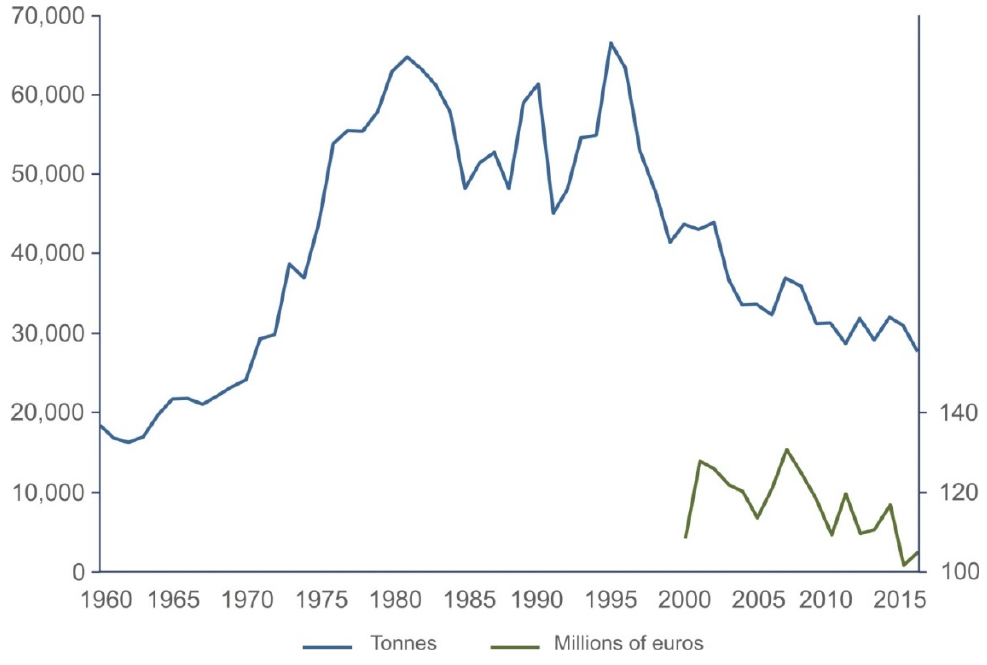
Figure 3. Total catches (1960–2017) and revenue (2000–2017) in Catalonia from commercial fishing (all types of fishing). Source: Prepared by the authors based on data from the Ministry and from the Government of Catalonia.